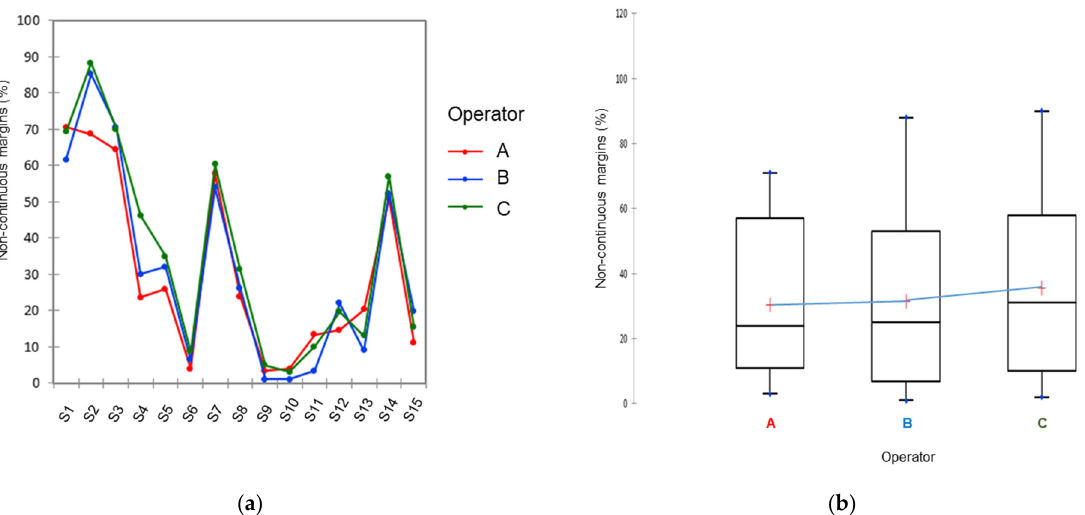
Figure 4. Bland and Altman plot showing the concordance between marginal analysis of the two methods. The mean difference between the methods is plotted with the solid blue line against the averages of the two methods and represents the bias. The blue dotted lines are +/- 95% confidence interval and the red dotted lines represent the limits of agreement. The majority of the observations are within the limits of agreement.